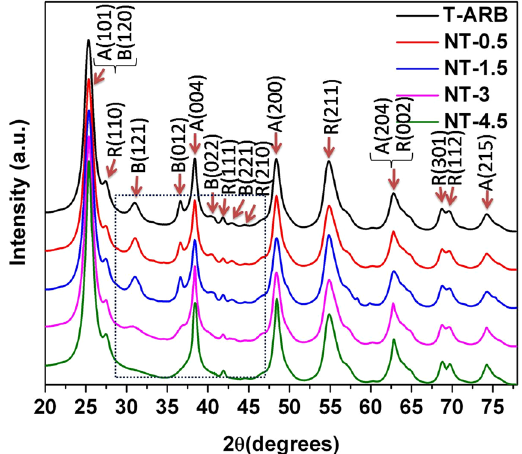
Figure 1. X-Ray diffraction patterns of pristine and N-TiO 2